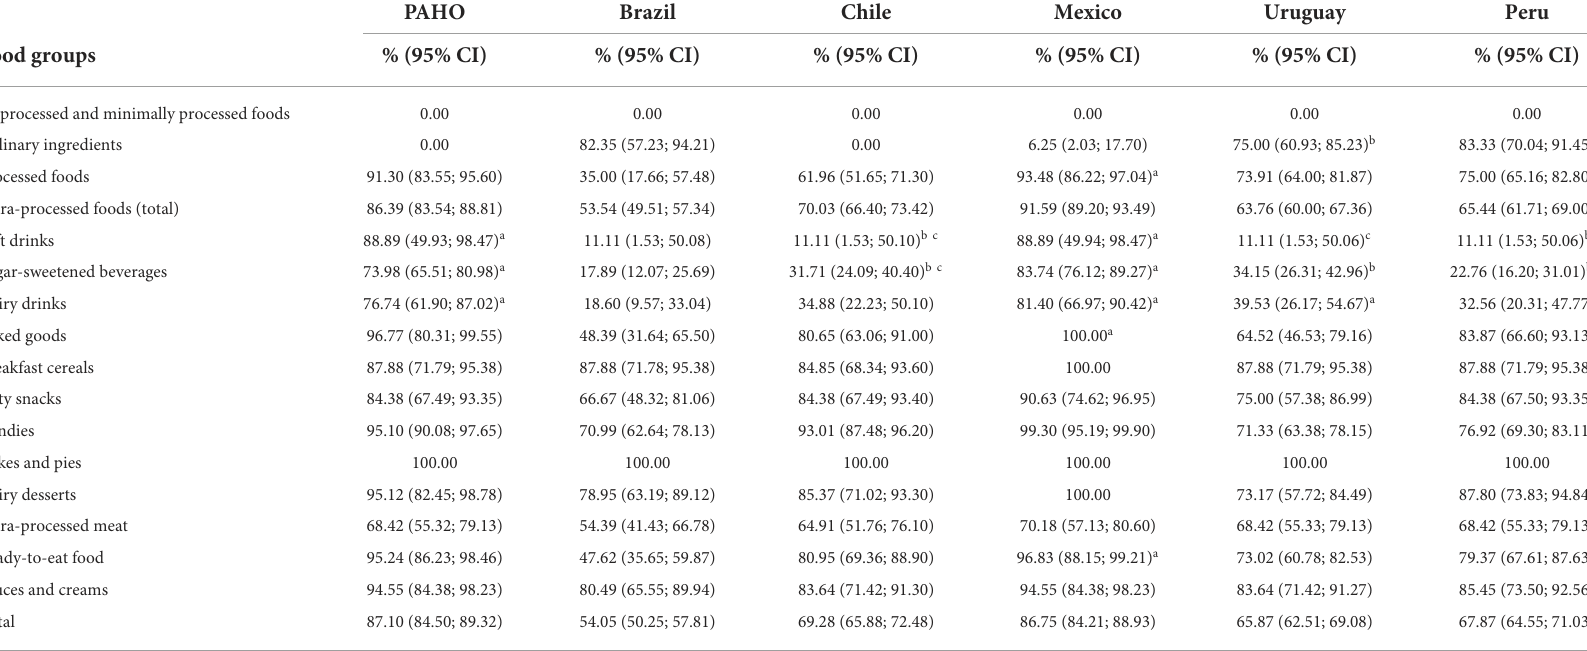
TABLE 3 Proportion (%) of foods and beverages with child-directed marketing and a high content of at least one nutrient of concern according to different nutrient profile models (NPMs), overall, and by food category (Brazil,